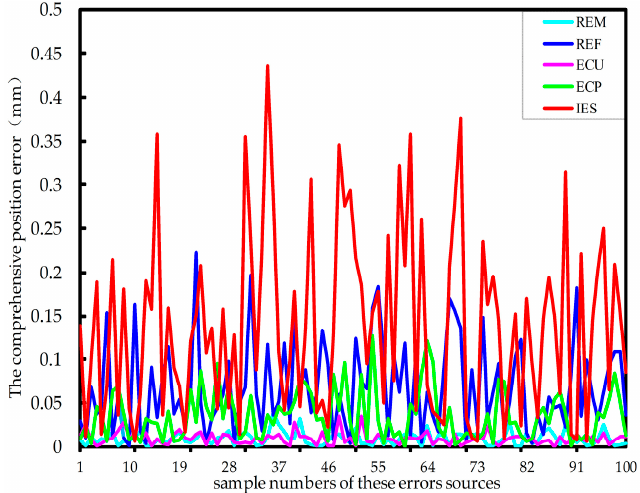
ECP and IES indicate the radius errors of the force-measuring platform and fixed platform, errors of two axial clearances for the middle universal joint and the lower positioning block and installation error of single-axis force sensor, respectively.